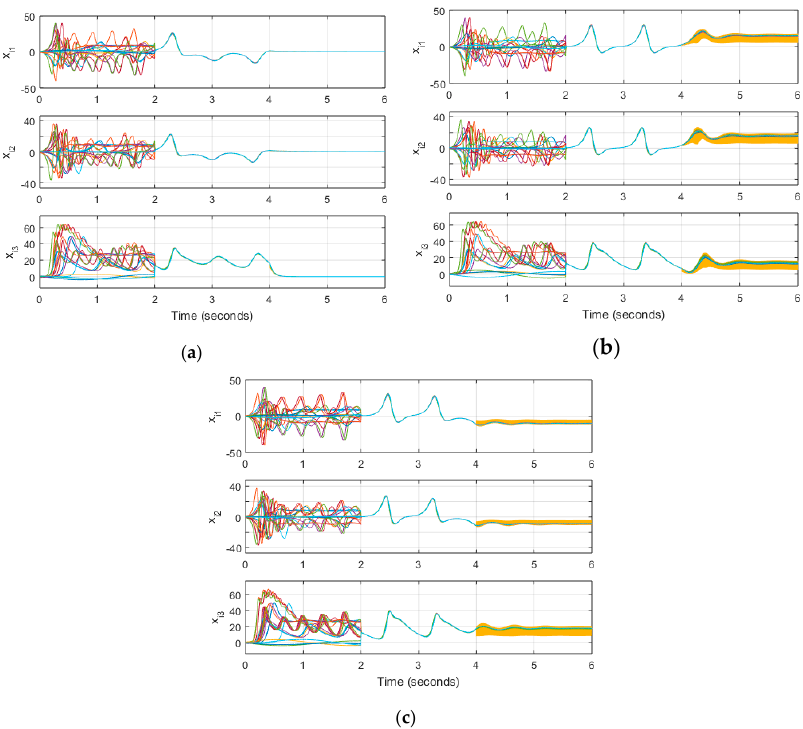
Figure 4. Complex network node dynamics when there is one controller, there is no noise in the system, control gain d 3 = 500, and: ( a ) Control input is applied at every time step; ( b ) Control input is applied every 5T; ( c ) Control input is applied every 10T.